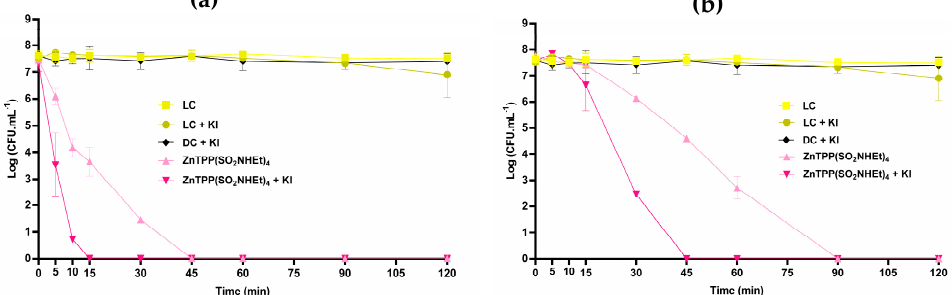
Figure 5. Photodynamic inactivation of MRSA in the presence of ZnTPP(SO 2 NHEt) 4 at 5.0 µ M ( a ) and 1.0 µ M ( b ), in the presence and absence of KI at 100 mM, during 120 min of irradiation (white light at an irradiance of 25 mW cm − 2 ). Each value represents the mean ± standard deviation of three independent assays, with three replicates each.